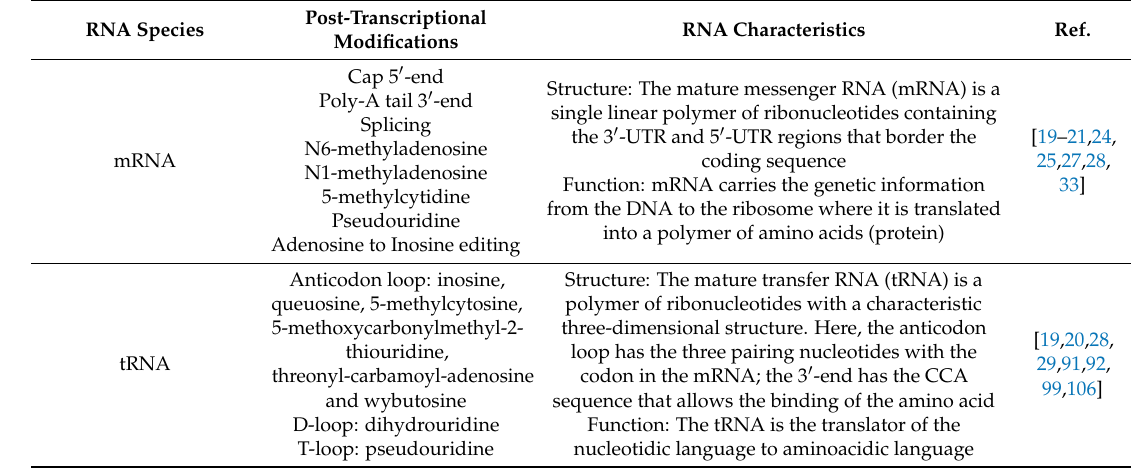
Table 1. Summary of the main characteristics and the more abundant epitranscriptomic modifications in coding RNA (mRNA), and noncoding-RNAs (tRNA, rRNA, lncRNA, miRNA, circRNA). Post-Transcriptional RNA Species RNA Characteristics Modifications